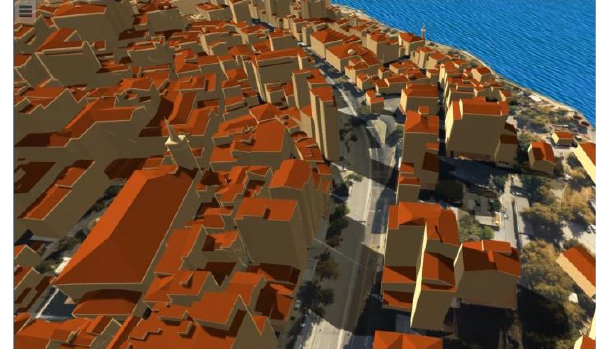
Figure 12. 3D visualization of 3D terrain information.